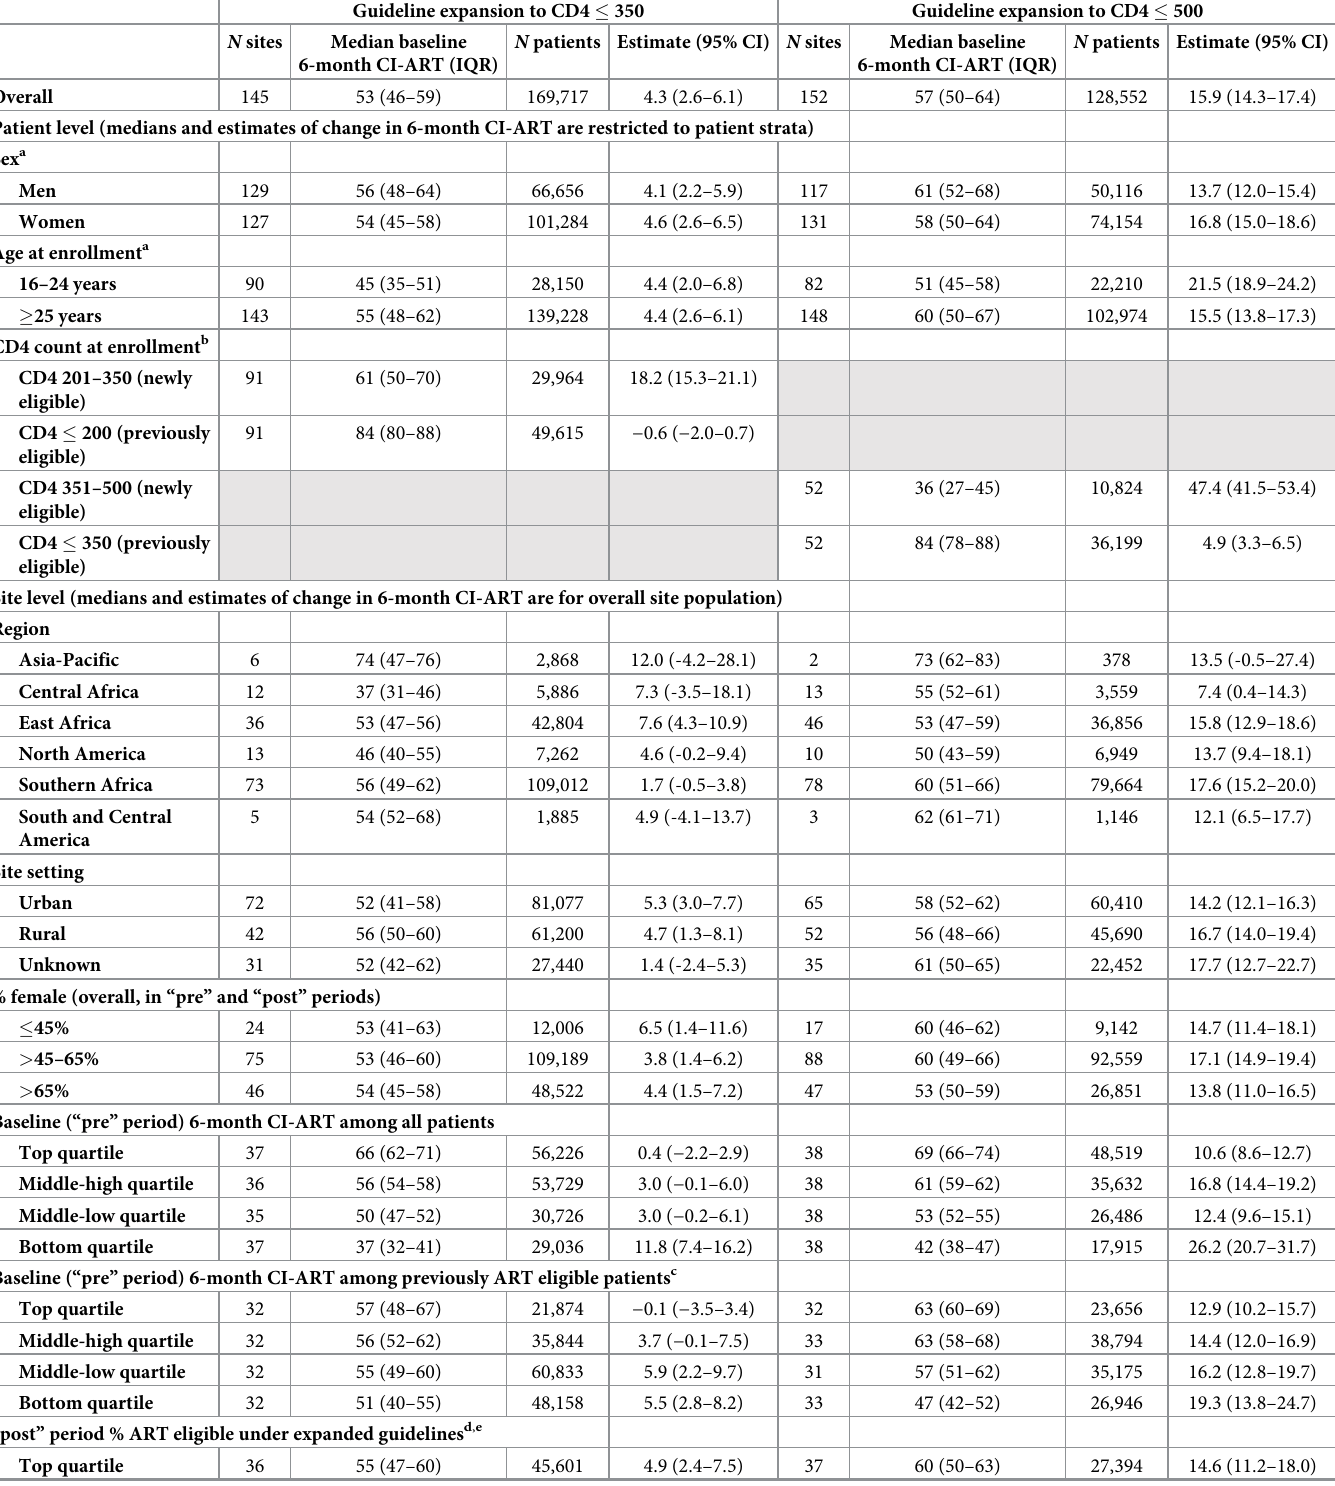
Table 2. Overall and pooled change in 6-month cumulative incidence of antiretroviral treatment initiation (CI-ART) after ART eligibility guideline expansion to CD4 (cid:20) 350 and CD4 (cid:20) 500. Guideline expansion to CD4 (cid:20)